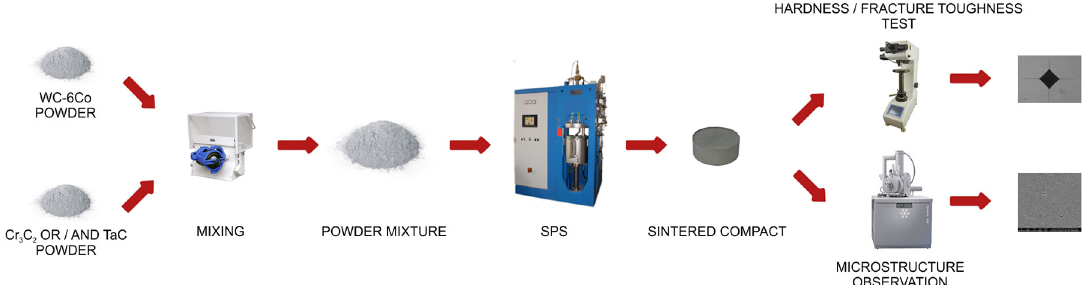
Figure 1. The scheme of the experimental procedure of the fabricating the WC-Co cemented carbide specimens and their examination.